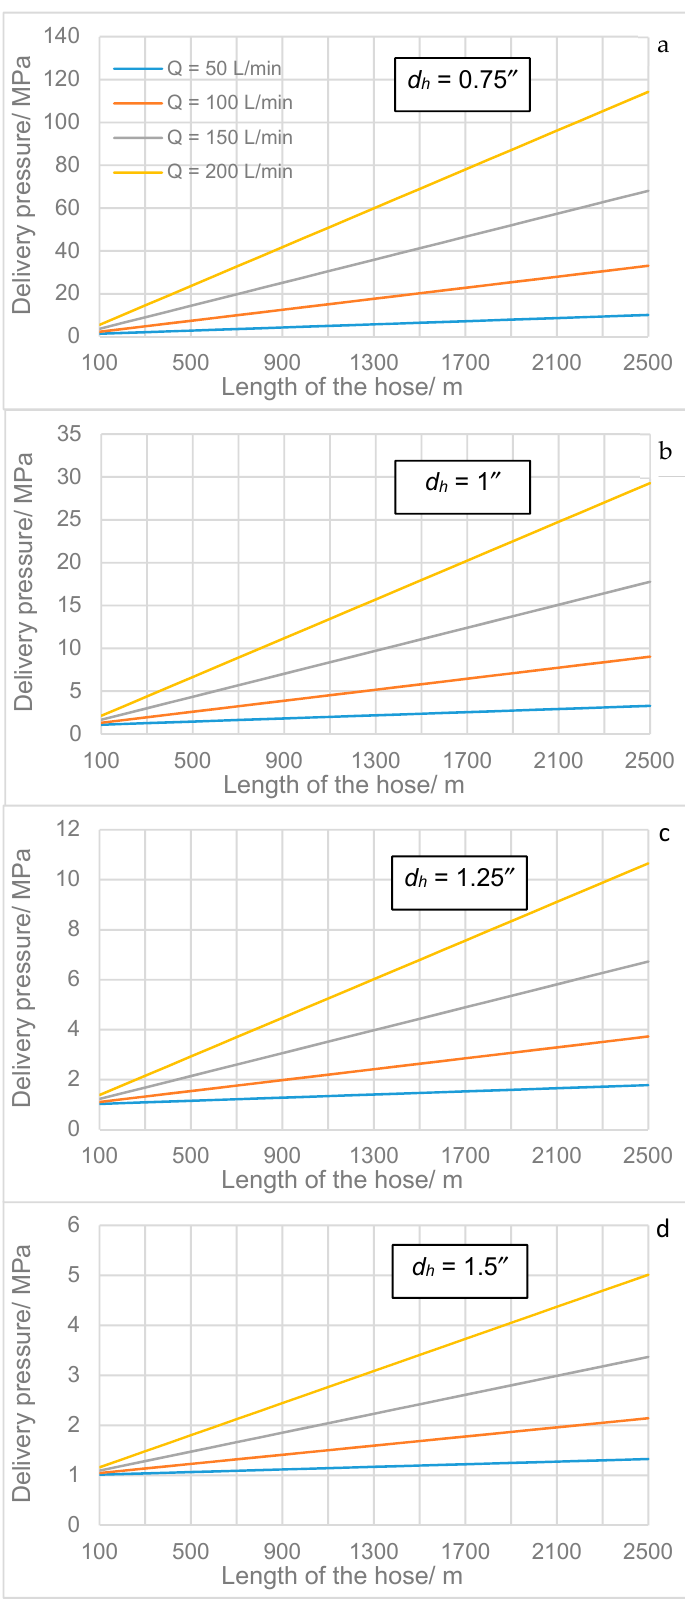
Figure 6. Required delivery pressure of hot water flow vs. length of the hose at different hose diameters ( a , 0.75 ″ ; b , 1 ″ ; c , 1.25 ″ ; d , 1.5 ″ ) and flow rates; local pressure losses are taken as 1 MPa.